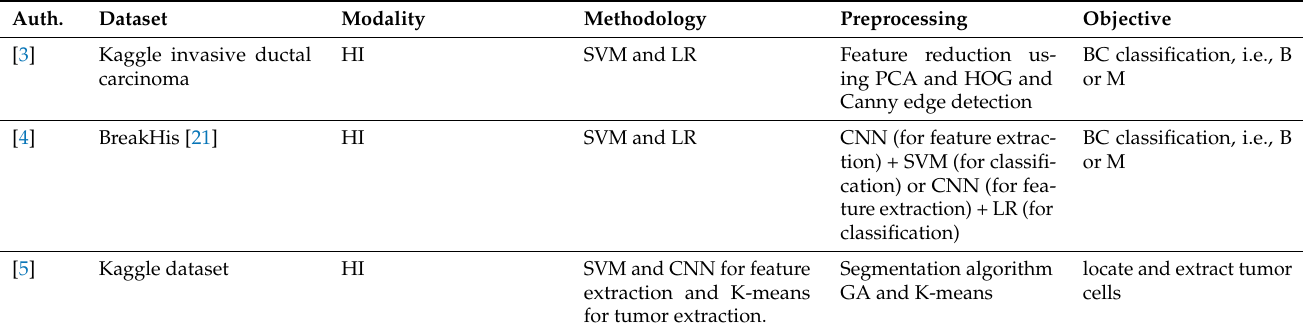
Table 4. Literature review for BC prediction using ML trained on histopathological images.